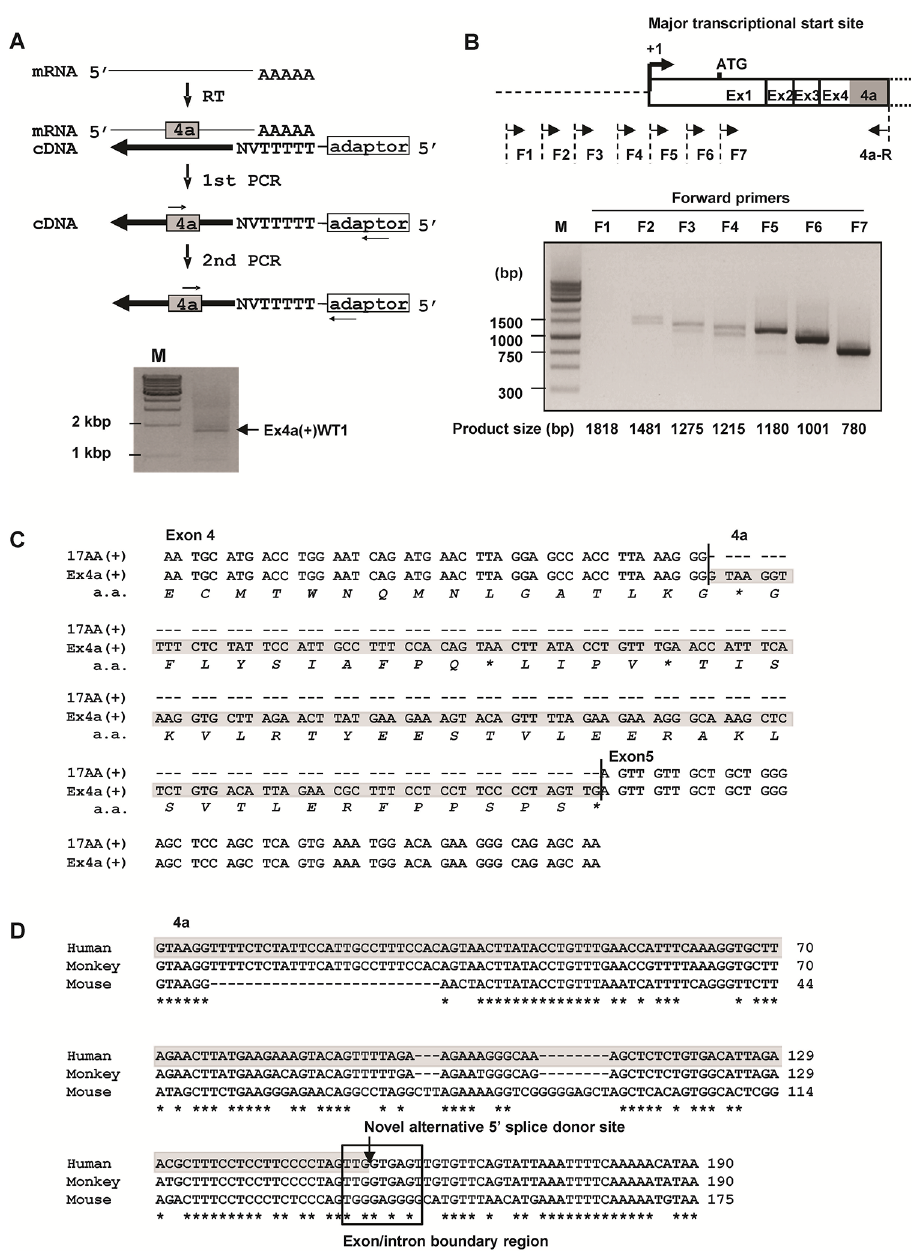
Fig 2. Cloning and sequence analysis of full-length Ex4a(+) WT1 isoform. ( A ) 3 ’ rapid amplification of cDNA ends (3 ’ RACE) assay. Upper, 3 ’ RACE overview. cDNA was synthesized by using a 3 ’ RACE adaptor- dT primer. First PCR was performed by using exon 4a-specific forward and adaptor outer reverse primers. Second nested PCR was performed by using the first PCR product as a template with the nested Ex4a(+) WT1 cDNA-specific forward and the nested adaptor inner reverse primers. Lower, Agarose gel electrophoresis of the second nested PCR products is shown. Lane M, molecular marker (1 kbp DNA ladder). ( B ) Transcriptional start site of Ex4a(+)WT1. Upper, Schematic representation of the primer locations used to determine the transcriptional start site of Ex4a(+)WT1. Four (F1, F2, F3 and F4) and three (F5, F6, and F7) forward primers are located upstream and downstream, respectively, of the major transcriptional start site of WT1. Reverse primer (4a-R) is located in Exon 4a. The arrows indicate the primer positions used for PCR. +1 represents the major transcription start site of WT1. ATG indicates translational start codon. Lower, Agarose gel electrophoresis of PCR products amplified by using one each of 7 forward and 4a-R primers is shown. Lane M, molecular marker (1 kbp DNA ladder). ( C ) Alignment of nucleotide sequence of human 17AA(+)WT1 (upper lane) and Ex4a(+)WT1 (lower lane), and amino-acid (aa) sequences of exons 4 and 4a are